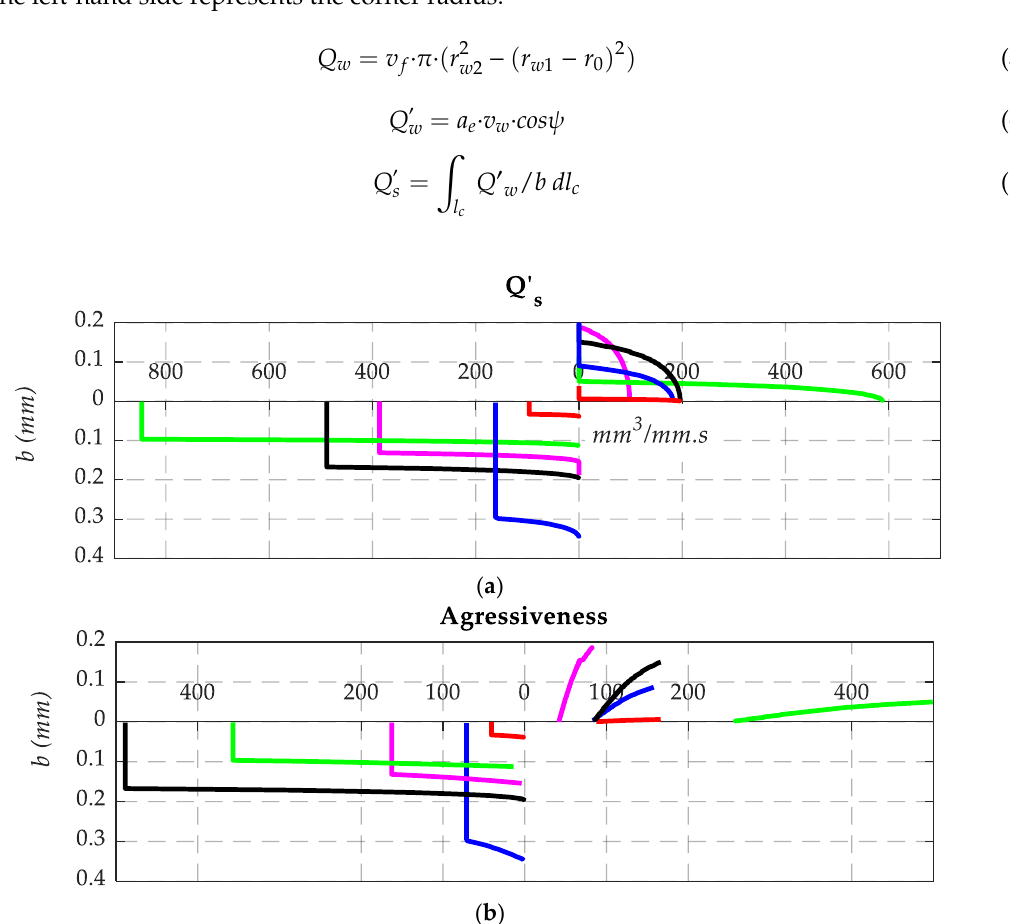
Figure 4. ( a ) Material removal rate in the wheel profile ( Q’ s ), ( b ) aggressiveness in the wheel profile.